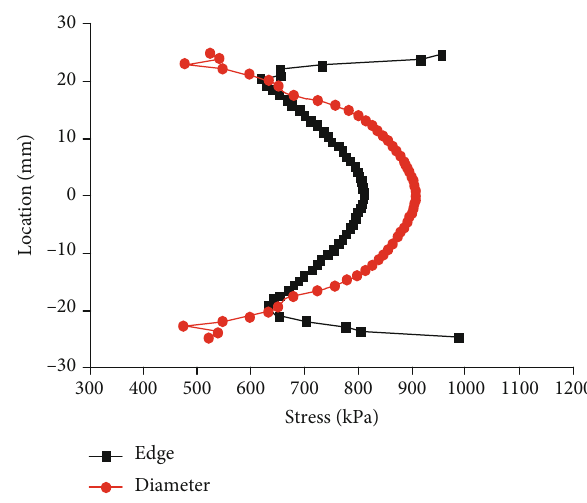
Figure 6: Central circular section equivalent stress distribution (10 ° , 14 ° , and 18 °